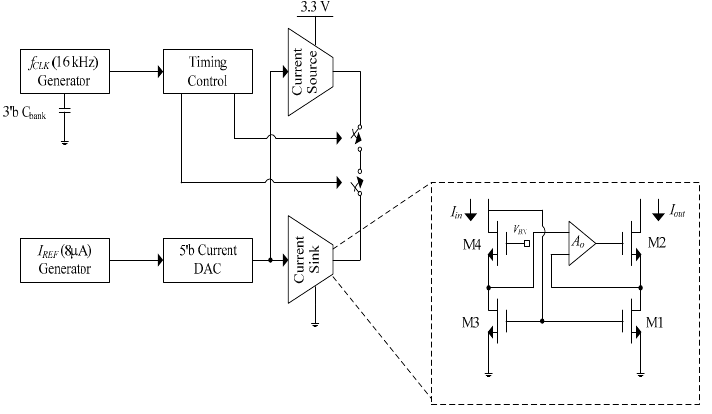
Figure 5. Block diagram of the current driver [11].